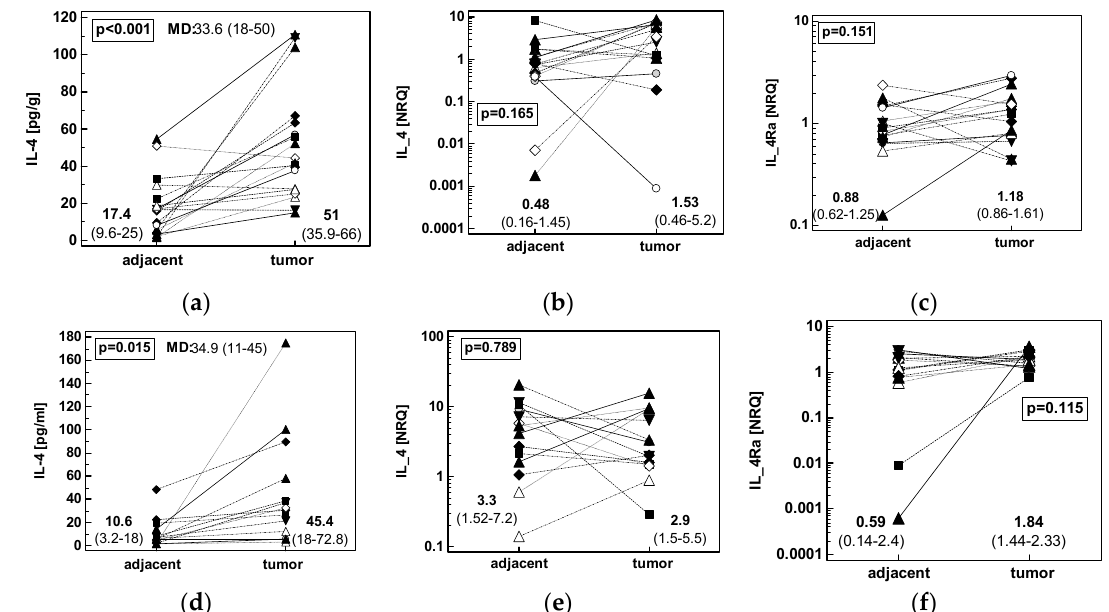
Figure 2. Patients’-matched analysis of tumor and tumor-adjacent tissue expression of: ( a ) IL-4 protein in ESCC ( n = 18); ( b ) IL4 mRNA in ESCC ( n = 16); ( c ) IL4Ra mRNA in ESCC ( n = 16); ( d ) IL-4 protein in GC ( n = 14); ( e ) IL4 mRNA in GC ( n = 14); ( f ) IL4Ra mRNA in GC ( n = 14). Data were analyzed as logs using t -test for paired samples and presented as geometric means with 95% confidence interval ( CI ). Mean difference in protein concentration (MD) between groups is accompanied by 95% CI . Transcriptomic data are presented as normalized relative quantities (NRQ). CRC, colorectal cancer; ESCC, esophageal squamous cell carcinoma; GC, gastric adenocarcinoma.